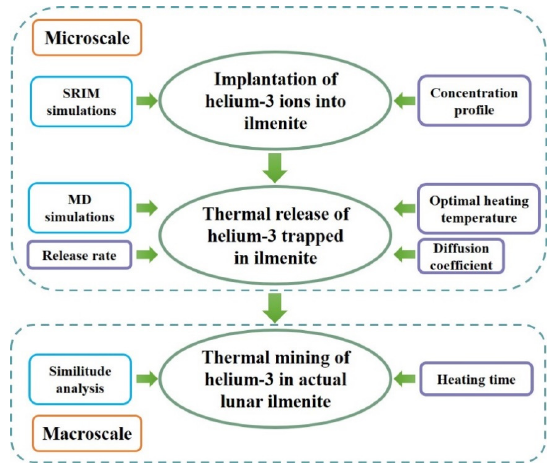
Figure 3. Flow chart of the calculation